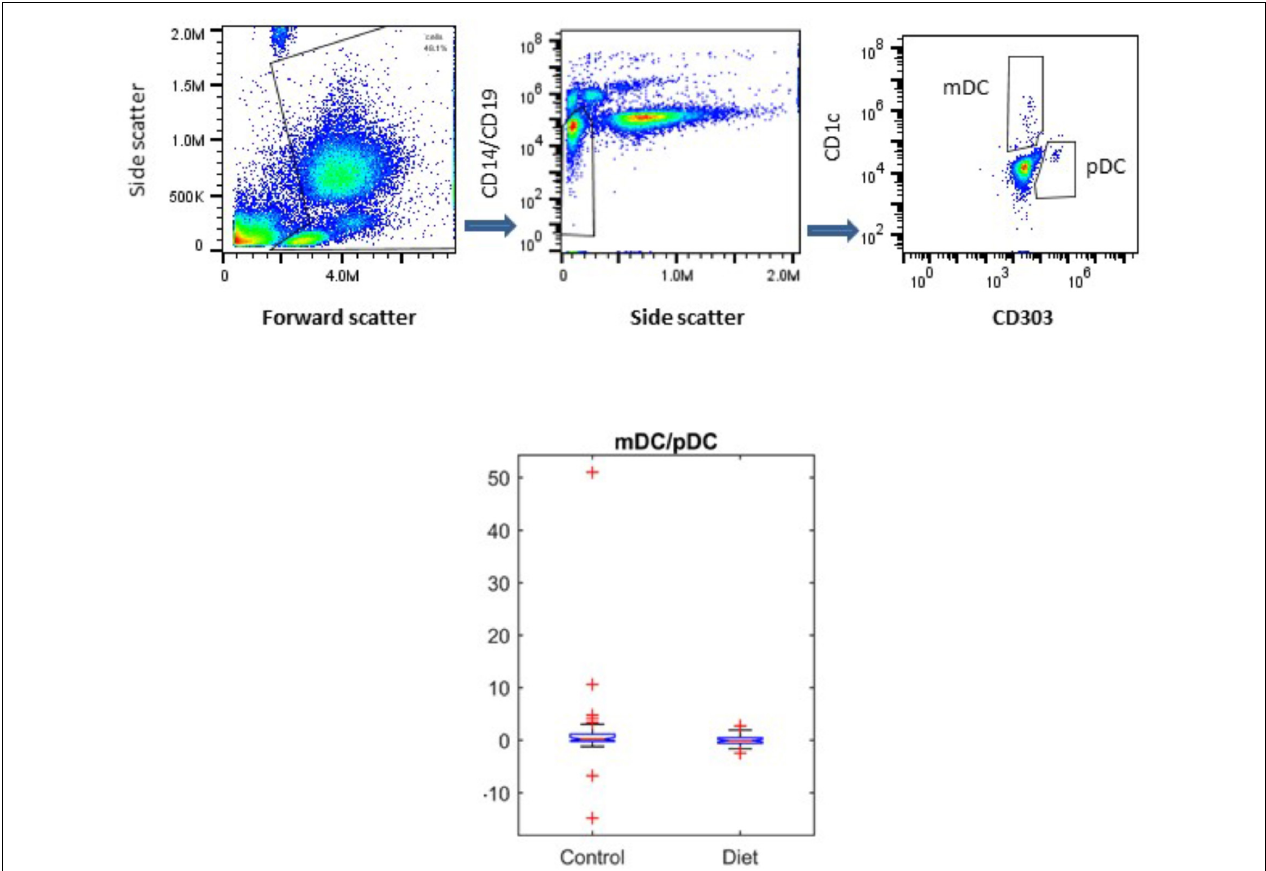
FIGURE 5 | Effects of MedDiet on dendritic cell (DC) subpopulations. Whole blood was used at baseline and at the end of the 1-year dietary intervention to determine myeloid (m)DC and plasmacytoid (p)DC ratio. Representation of the gating strategy for the DCs enumeration is shown in (A–C) . (D) Boxplot showing the difference in the control and diet groups for mDC/pDC ratio right panel. A decrease, but not statistically significant of the ratio of mDC/pDC ( P = 0.0536) was observed.